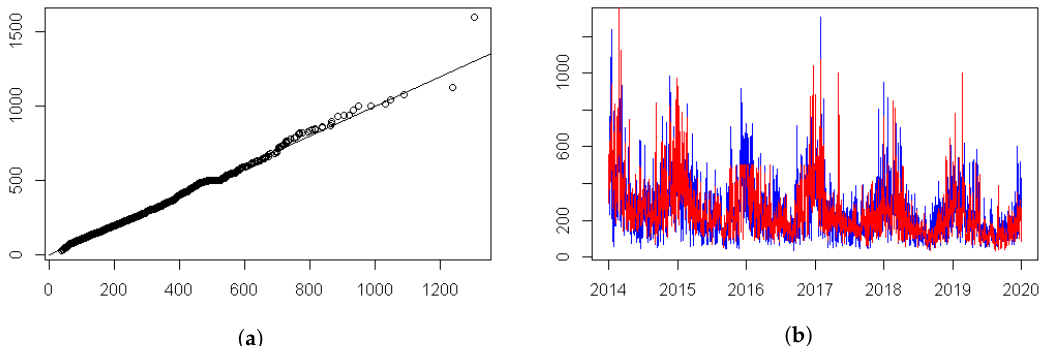
Figure 11. ( a ) The QQ-plot of the ˜ Q t ( µ g/m 3 ) with weather factors ( x -axis) and real Q t ( y -axis, µ g/m 3 ); ( b ) the line graphs of ˜ Q t (blue lines, µ g/m 3 ) and real Q t (red lines, µ g/m 3